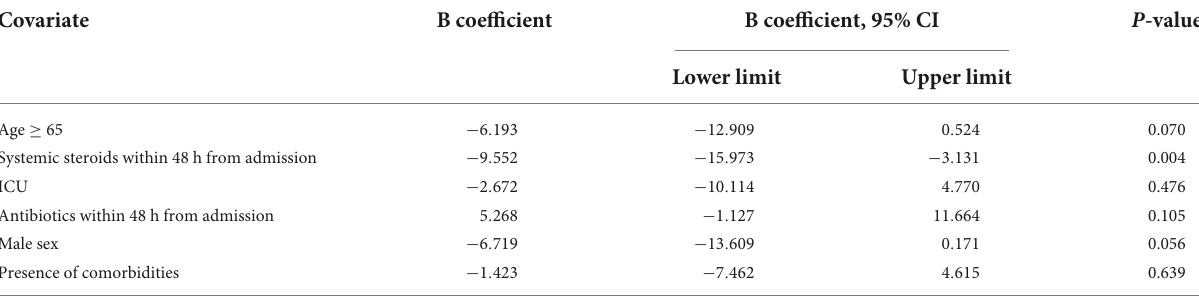
TABLE 3 Multivariate linear regression model of factors affecting time from hospital admission to first positive blood culture. Covariate B